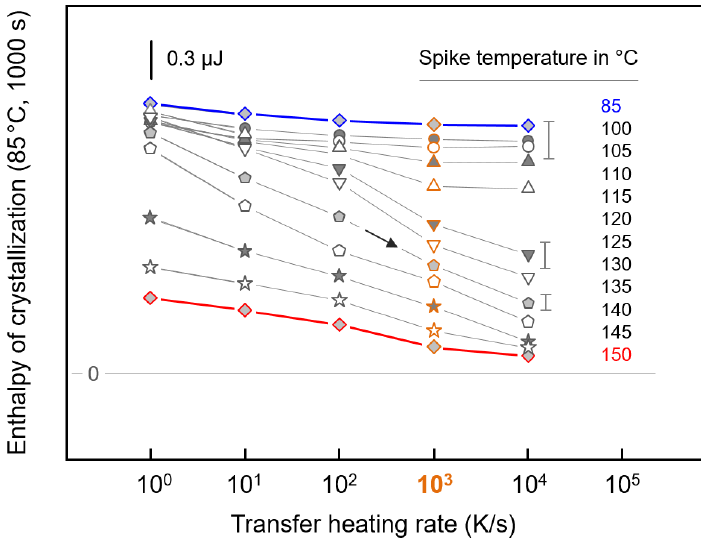
Figure 6. Enthalpy of the crystallization of PBI at 85 ◦ C for 1000 s as a function of the rate of heating crystal nuclei formed at 50 ◦ C for 5000 s to di ff erent spike temperatures between 85 ◦ C (blue) and 150 ◦ C (red), as indicated to the right of the various data sets. Data sets for spike temperatures of 85, 100, 110, 120, 130, 140, and 150 ◦ C represent averages of two independent measurements using di ff erent samples and FSC sensors, with typical error bars shown to the right. Orange-colored symbols, associated with experiments using a transfer heating rate of 1000 K / s, provide a link to Figure 4, as further explained in the text.